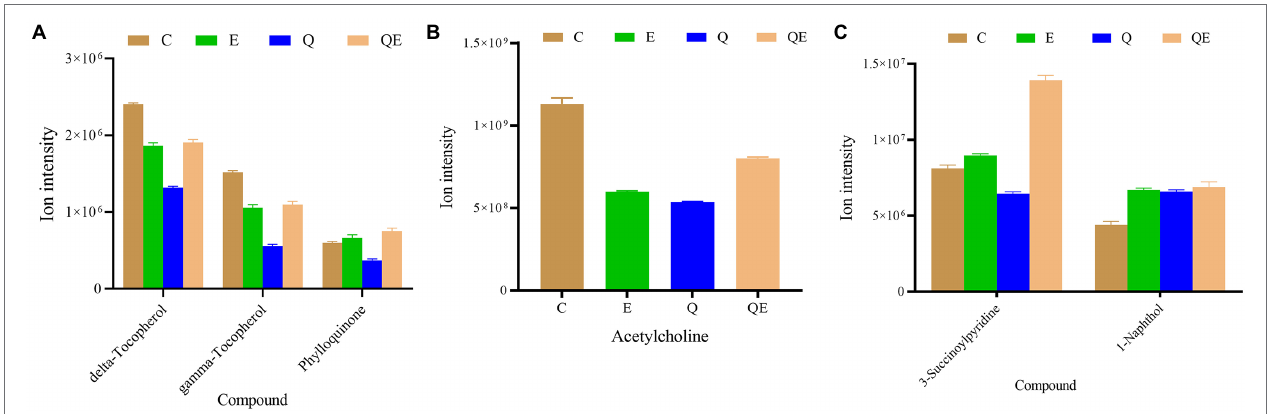
FIGURE 7 | Ion intensities of metabolites involved in differentially expressed pathways by Kyoto Encyclopedia of Genes and Genomes among the aged breeder chickens (control group (C), quercetin group (Q), vitamin E group (E), and QE). (A) Ubiquinone and other terpenoid–quinone biosynthesis (delta-Tocopherol, gamma- Tocopherol, and Phylloquinone). (B) Regulation of actin cytoskeleton, Insulin secretion, Pancreatic secretion, and Nicotine addiction (Acetylcholine). (C) Metabolism of xenobiotics by cytochrome P450 (3-Succinoylpyridine and